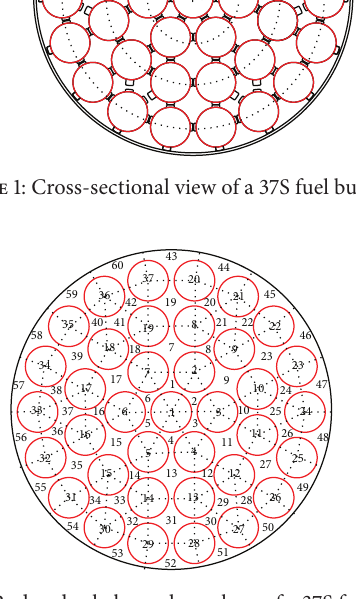
fuel elements to configure a bundle structure. Twelve